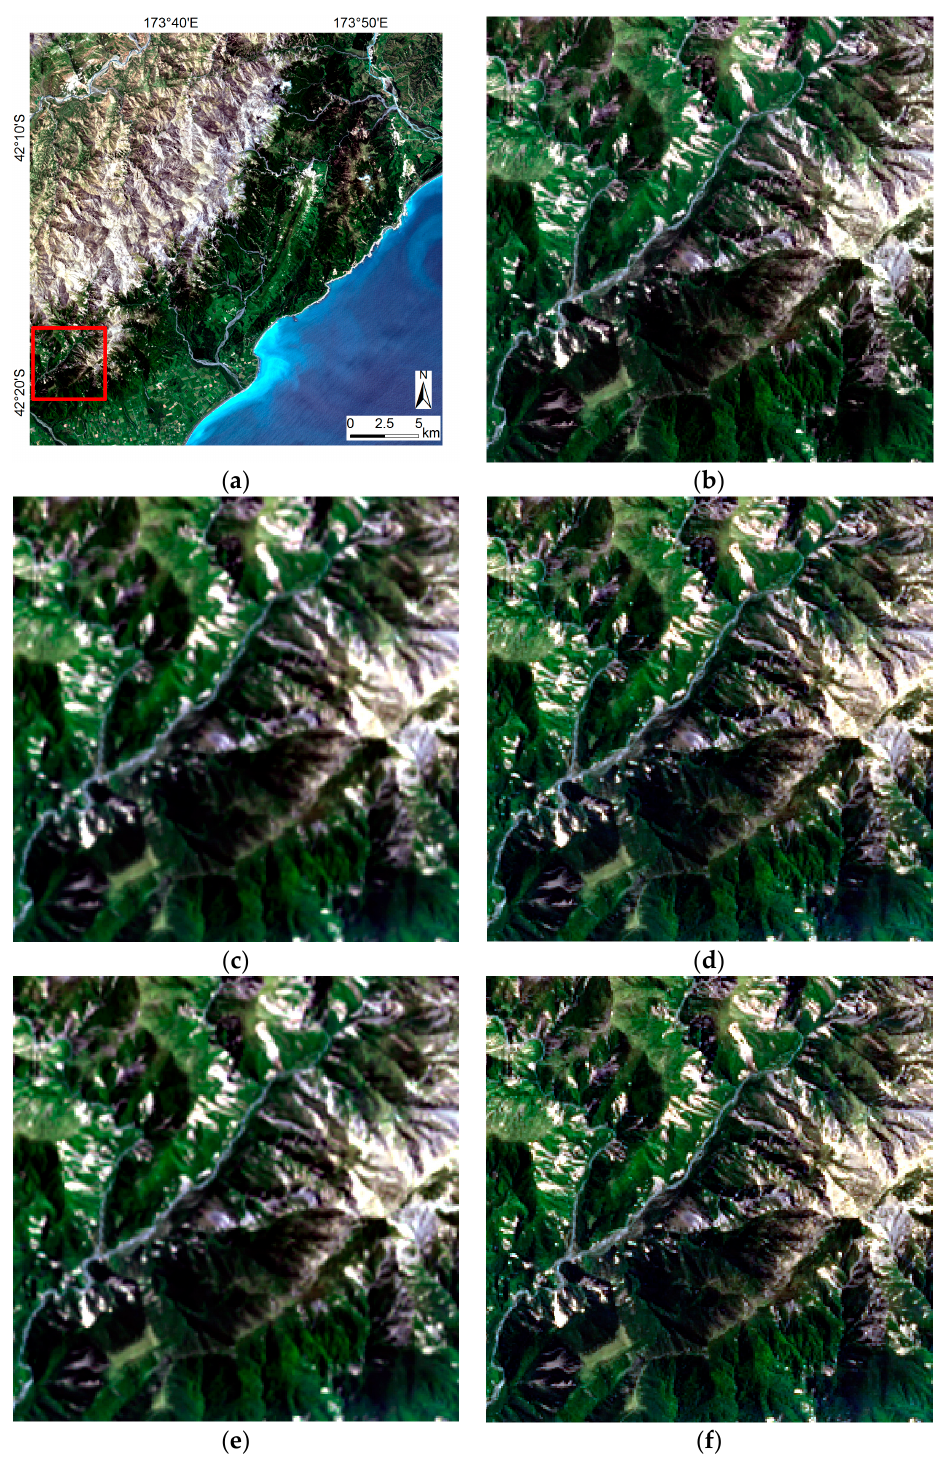
Figure 7. Mountain landslides, New Zealand, true color images showing: ( a ) Sentinel-2A 20-m image (1500 × 1500 20-m pixels) and sub-set (red box); ( b ) Sentinel-2A 256 × 256 20-m pixel sub-area; ( c ) Landsat-8 bilinear resampled to 20 m; ( d ) Landsat-8 bilinear-based LPAD 20-m data; ( e ) Landsat-8 cubic convolution resampled to 20 m; ( f ) Landsat-8 cubic convolution-based LPAD 20-m data.